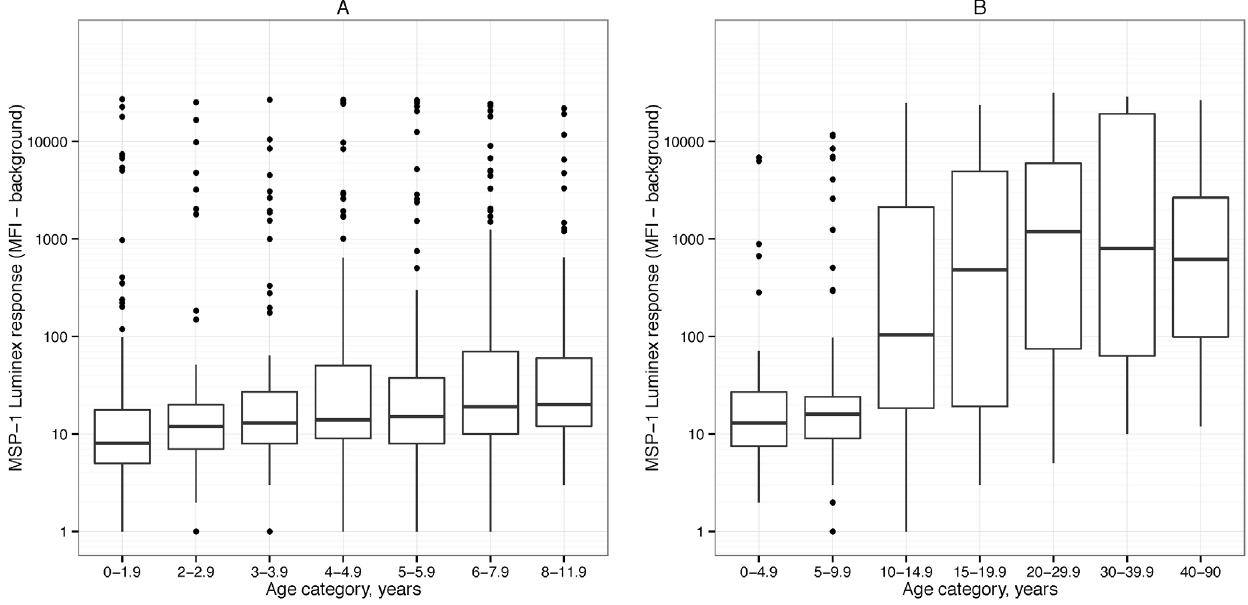
Figure 1. MSP-1 19 antibody optical density responses for different age categories. Panel A includes antibody responses from the longitudinal study in Le´ogaˆne, Haiti, 1991–1999. Panel B includes antibody responses from the cross-sectional survey in Miton, Haiti, 1998.